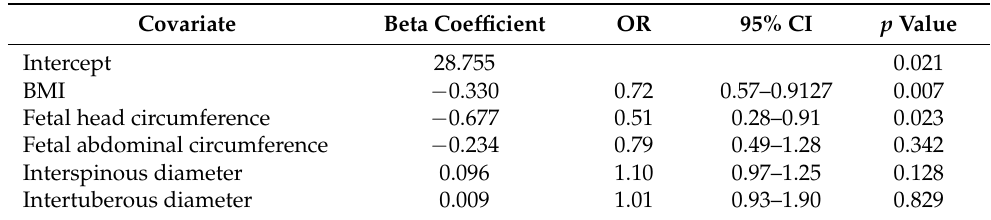
Table 3. The Predictive Model for Vaginal Birth in the Training Set Using Multivariate Logistic Regression ( n =